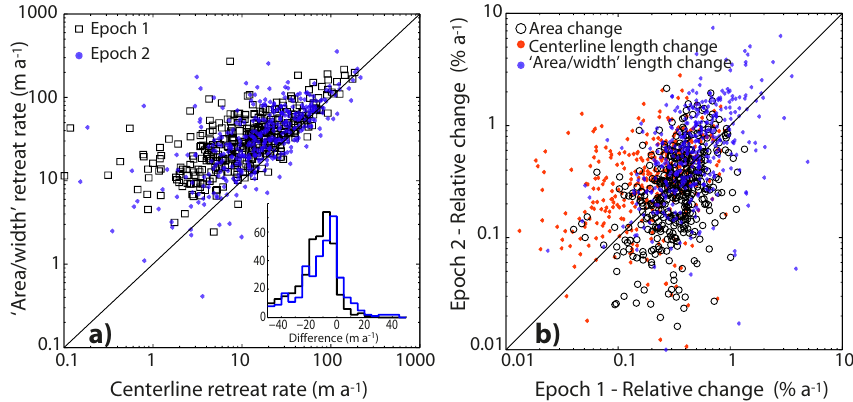
Fig. 7. (a) Temporal mean retreat rates for Epoch 1 and 2, as estimated from the centerline differences and by the area change divided by tongue width (“Area/width”). The inset shows the histogram of differences between the two retreat rate estimates. The “Area/width” retreat rates are larger than the centerline due to both incorporation of lateral losses in the area-width retreat rate estimate and a lack of representative retreat sampling of the centerline. (b) Relative changes during Epoch 1 and Epoch 2 for area changes, centerline length changes and the “Area/width” length changes.